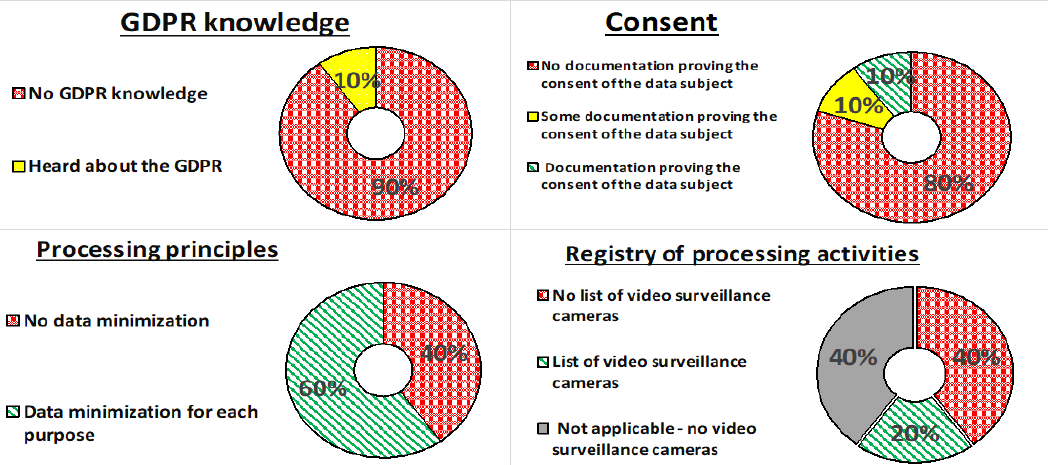
Figure 1. Knowledge, consent, processing principles and registry of processing